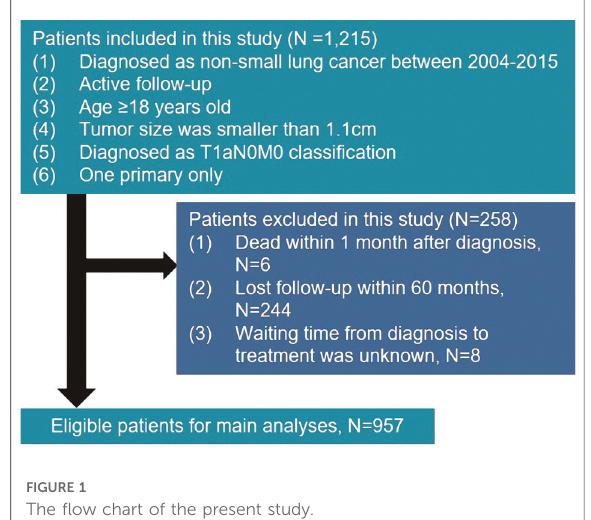
FIGURE 1 The fl ow chart of the present